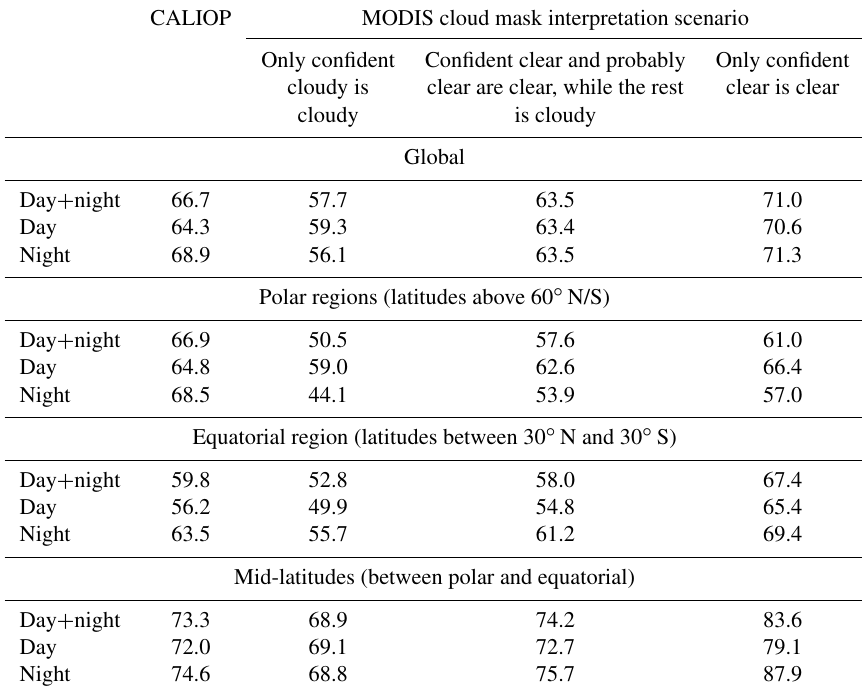
Table 4. Global cloud amount (%) calculated with different best-guess interpretations of the MODIS cloud mask product. Only MODIS IFOVs collocated with CALIOP are considered. CALIOP MODIS cloud mask interpretation scenario Only confident Confident clear and probably Only confident cloudy is clear are clear, while the rest clear is clear cloudy is cloudy Global